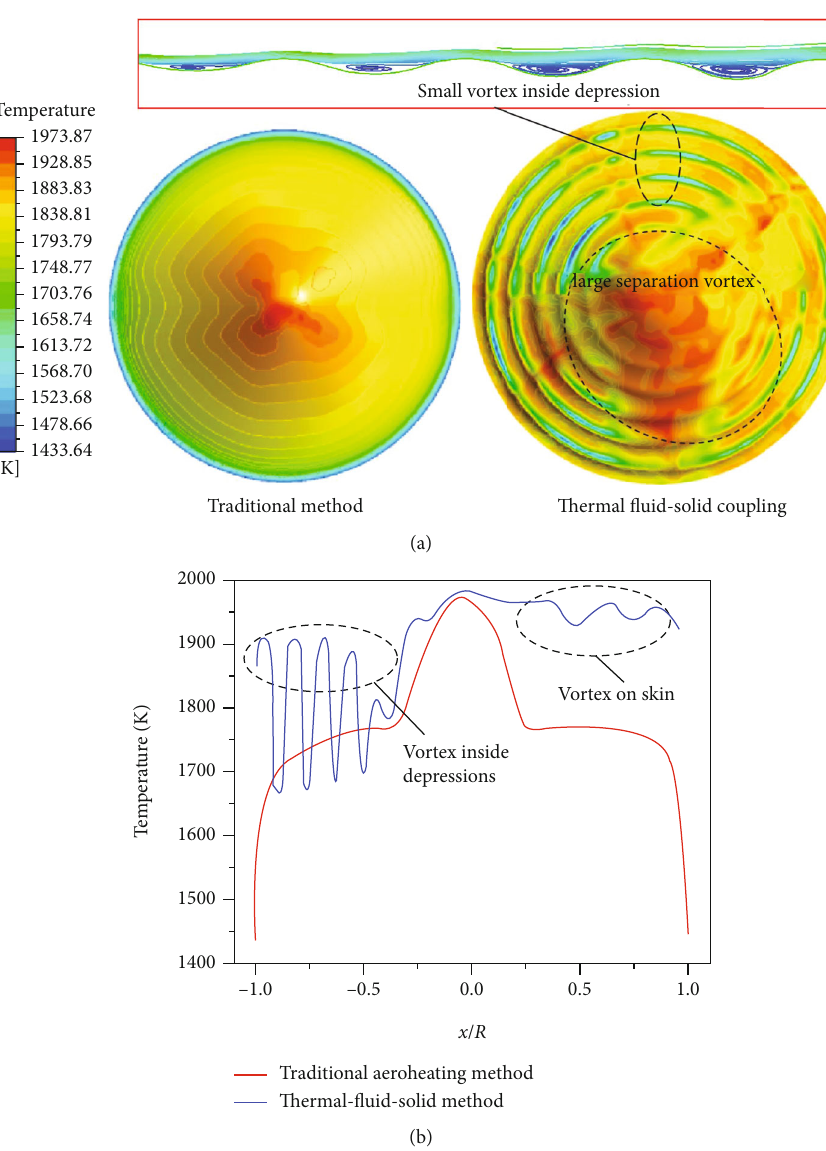
Figure 13: Comparison of temperature on windward skin: (a) nephograms; (b) curves.